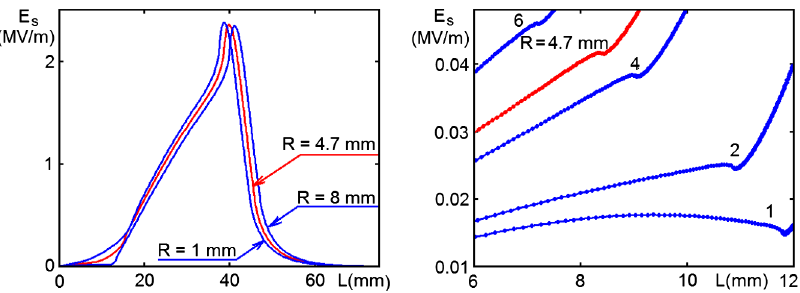
calculations.FIG. 2. Surface electric field along the profile line of the cavity. L is distance from the equator. The right figure is not a direct expansion of the left one: more curves are in the right figure to show a shift of the minimum in detail.